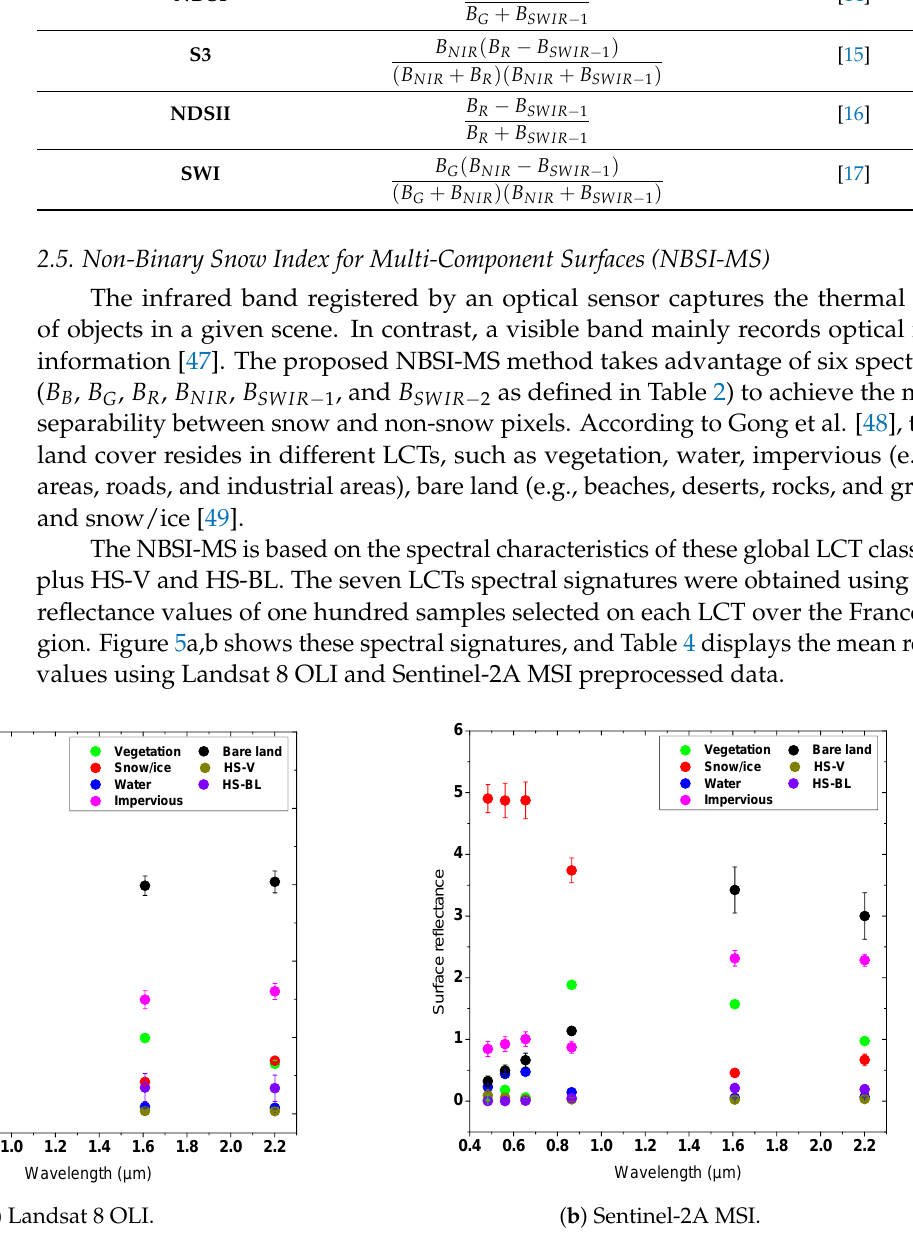
Figure 5. Spectral signatures (mean ± standard deviation) for ( a ) Landsat OLI 8 and ( b ) Sentinel 2A MSI. The signatures were obtained by averaging over 100 pixels selected in each Land Cover Type. Note: HS-BL is the Hilly Shadow over Bare Land, and HS-V is the Hilly Shadow over